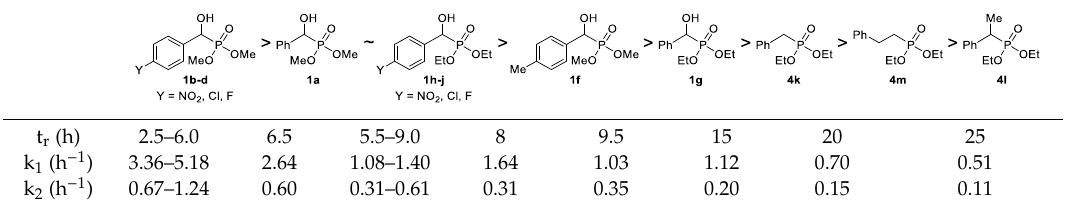
Table 3. Reactivity order of the phosphonates 1a–j and 4k–m in acidic hydrolyses characterized by t r , as well as k 1 and k 2 .